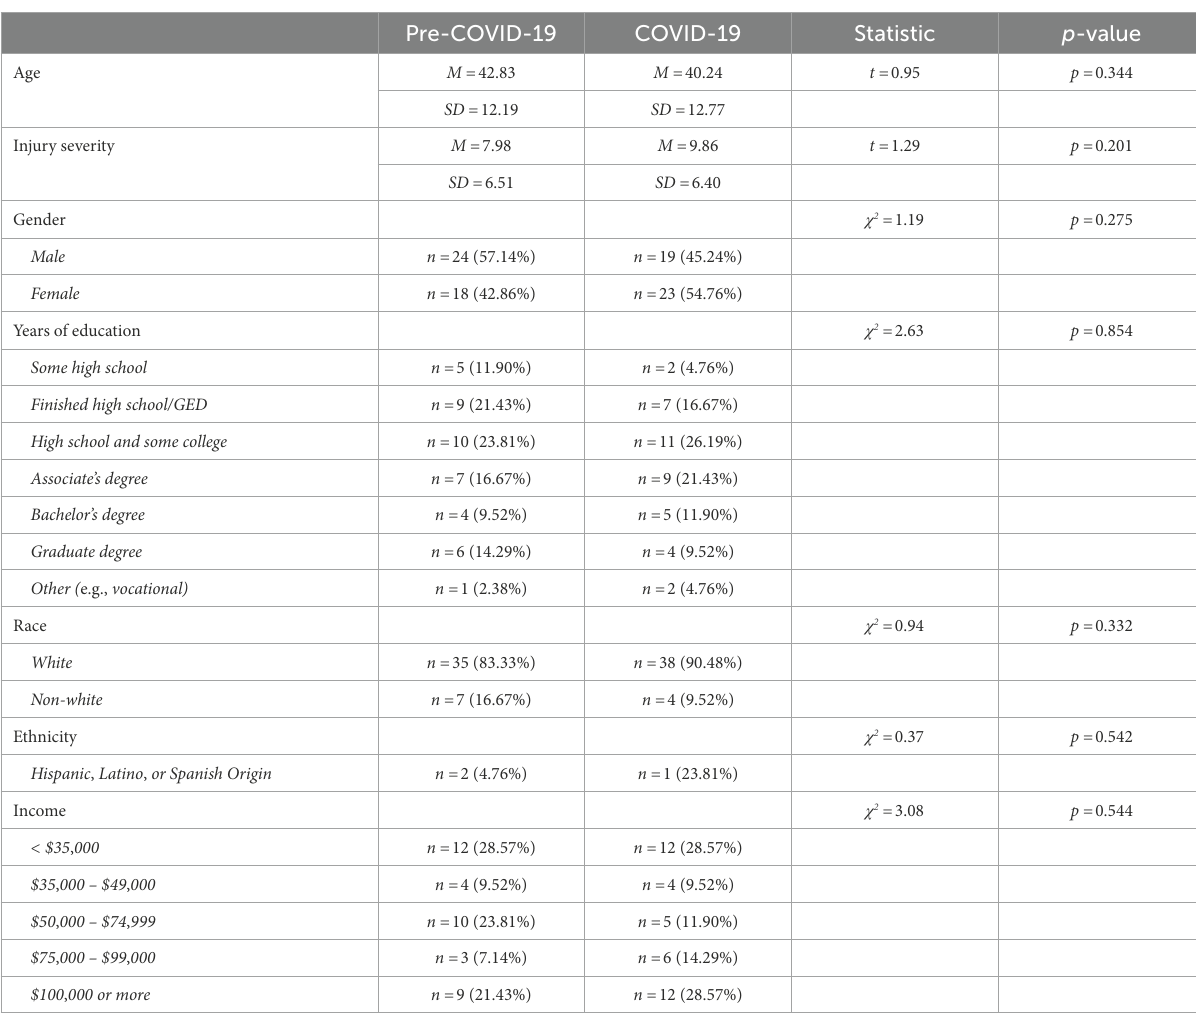
TABLE 1 Sample characteristics and cohort